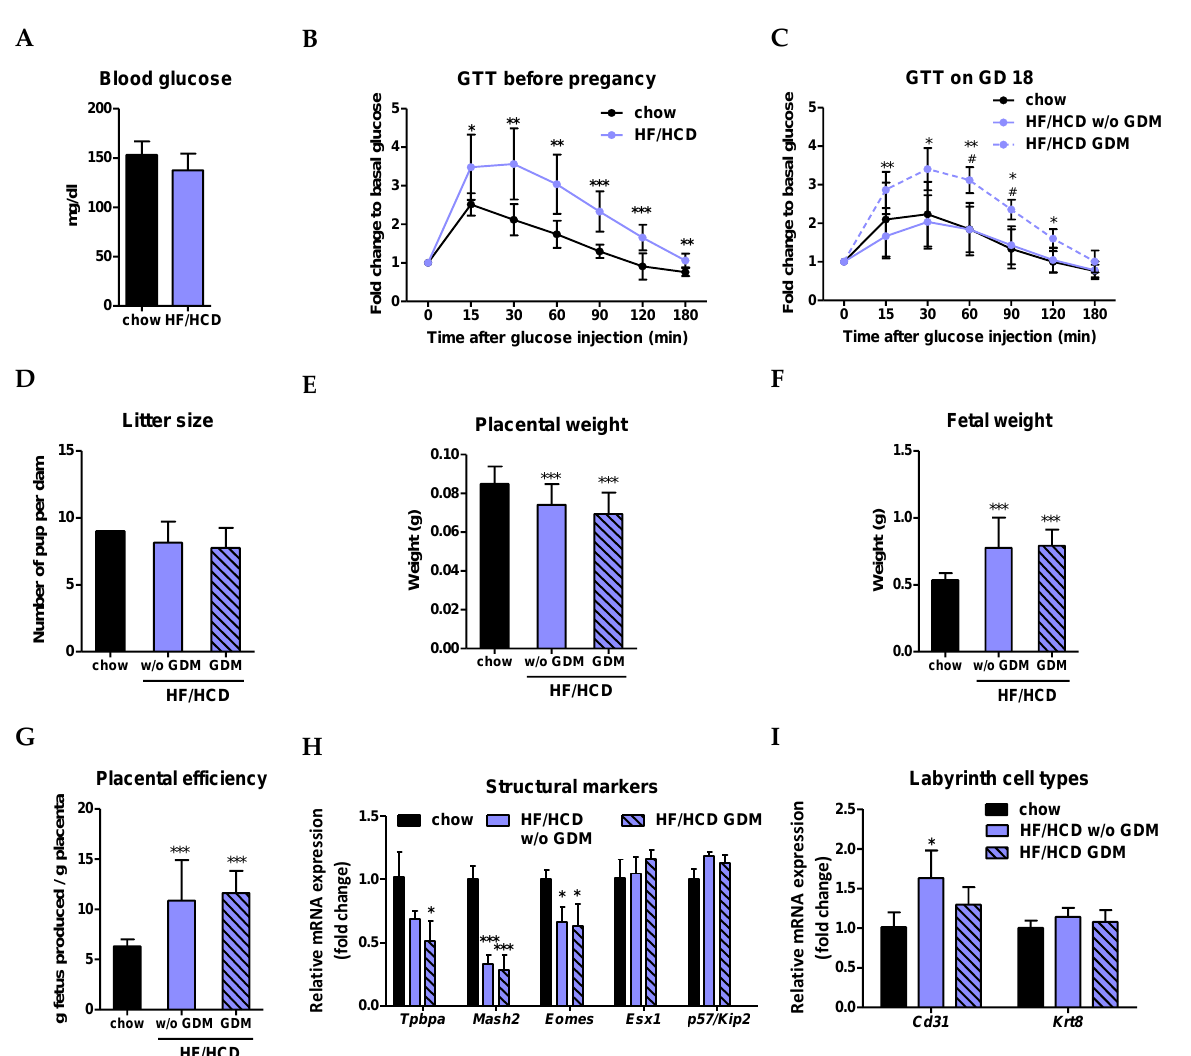
Figure 1. Increased placental efficiency after HF/HCD feeding and in GDM at the end of pregnancy. ( A ) Blood glucose levels after 6 h of fasting and ( B ) glucose tolerance test (GTT) before pregnancy ( n = 3 chow, 9 HF/HCD). ( C ) GTT at gestational day (GD) 18 ( n = 3 chow, 8 HF/HCD w/o GDM, 4 HF/HCD GDM). ( D ) Number of pups per dam indicated as litter size ( n = 3 chow, 8 HF/HCD